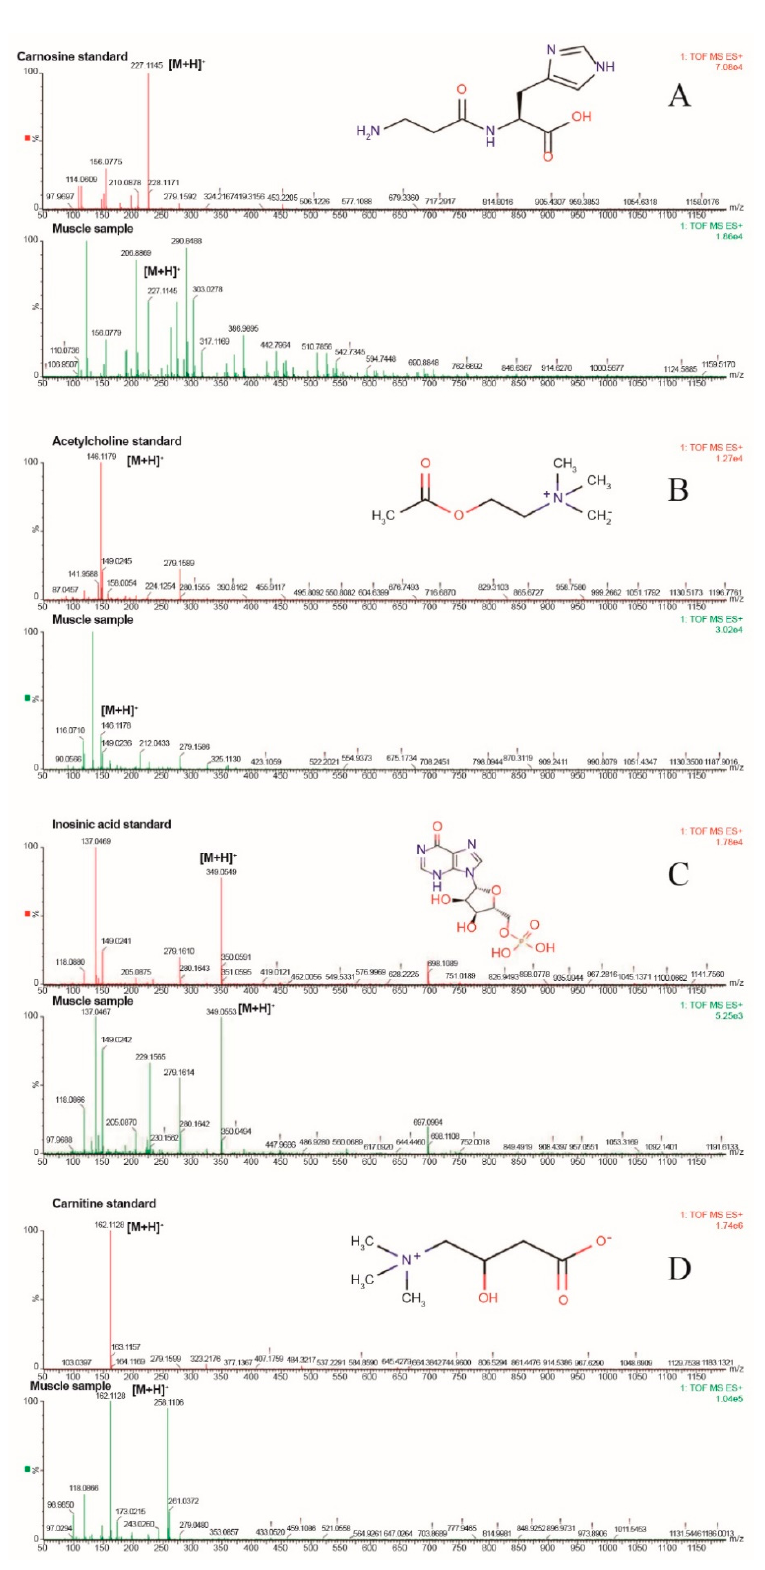
Figure 3. Mass spectra of authentic metabolite standards and muscle samples. Note: The t R and m / z of the authentic standard of metabolites were identical to the LD muscle sample: ( A ) carnosine, ( B ) acetylcholine, ( C ) inosinic acid, and ( D ) carnitine.